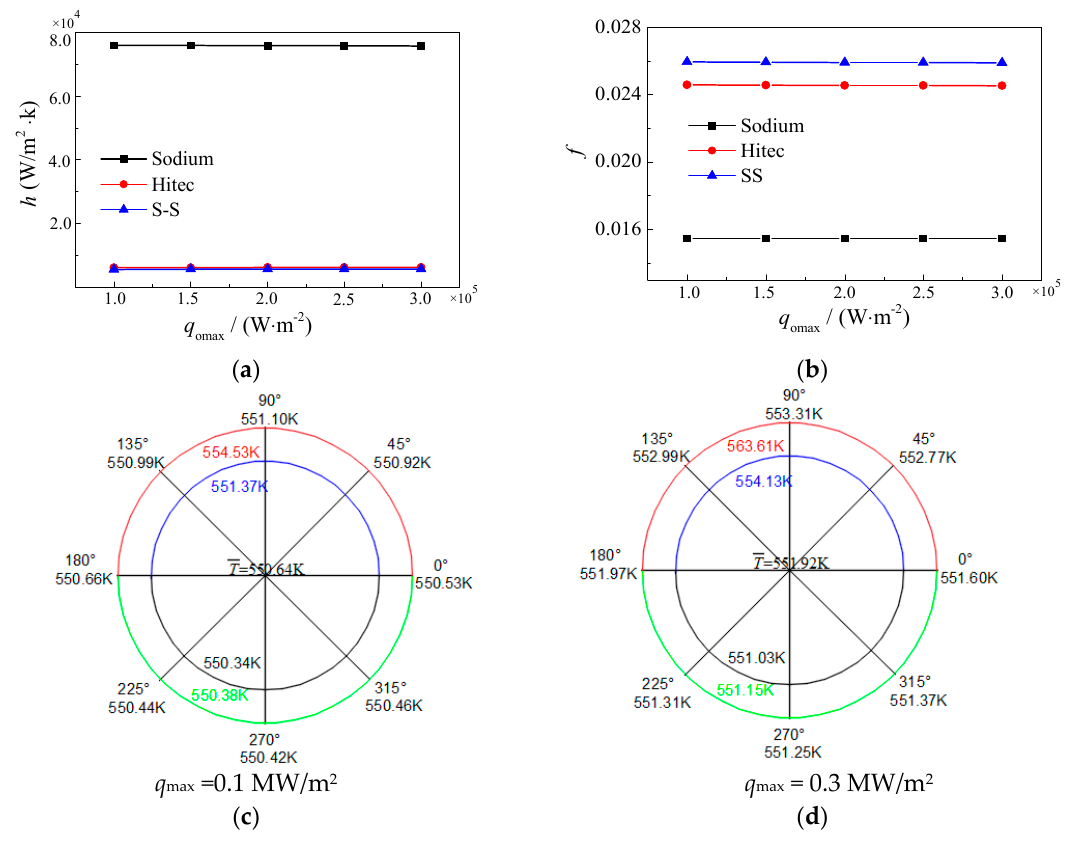
Figure 12. Effects of q o max : ( a ) q o max - h , ( b ) q o max - f , ( c – d ) q o max - T. Figure 12. E ff ects of q o max : ( a ) q o max - h , ( b ) q o max - f , ( c , d ) q o max -